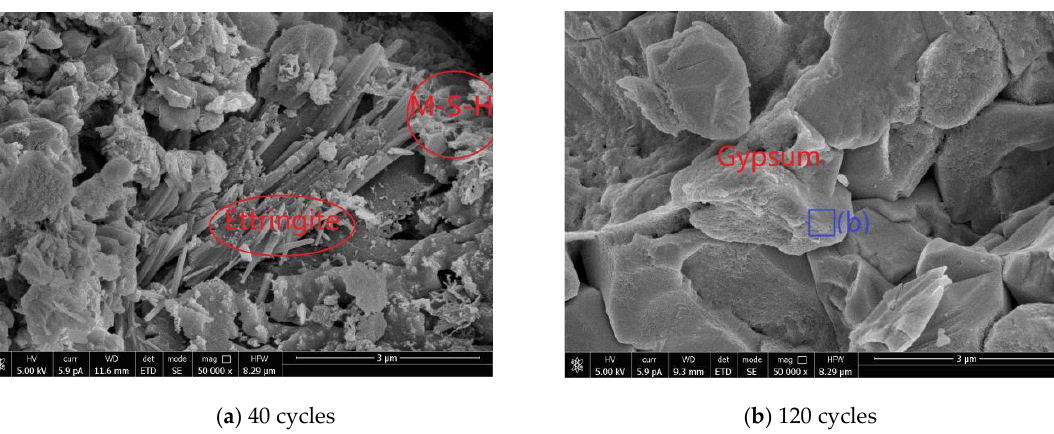
Figure 21. Microscopic morphology of MK concrete eroded by Na 2 SO 4 solution.